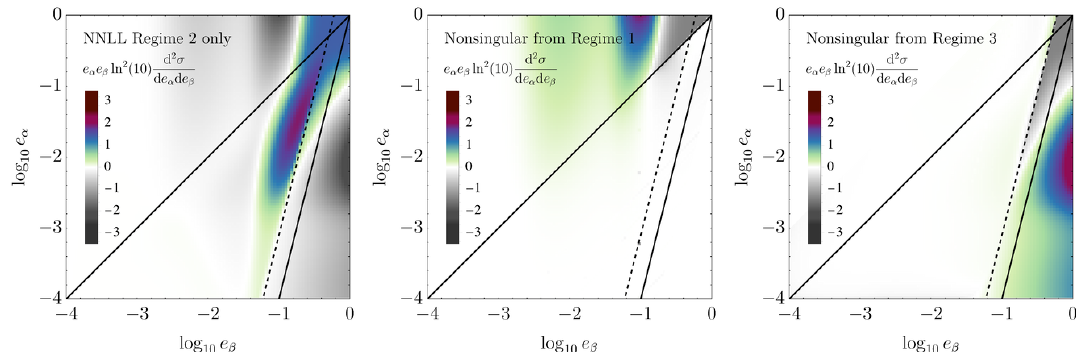
Figure 5 . NNLL cross section in regime 2 (left) and nonsingular corrections from regimes 1 (center) and 3 (right), corresponding to the second and third line of eq.